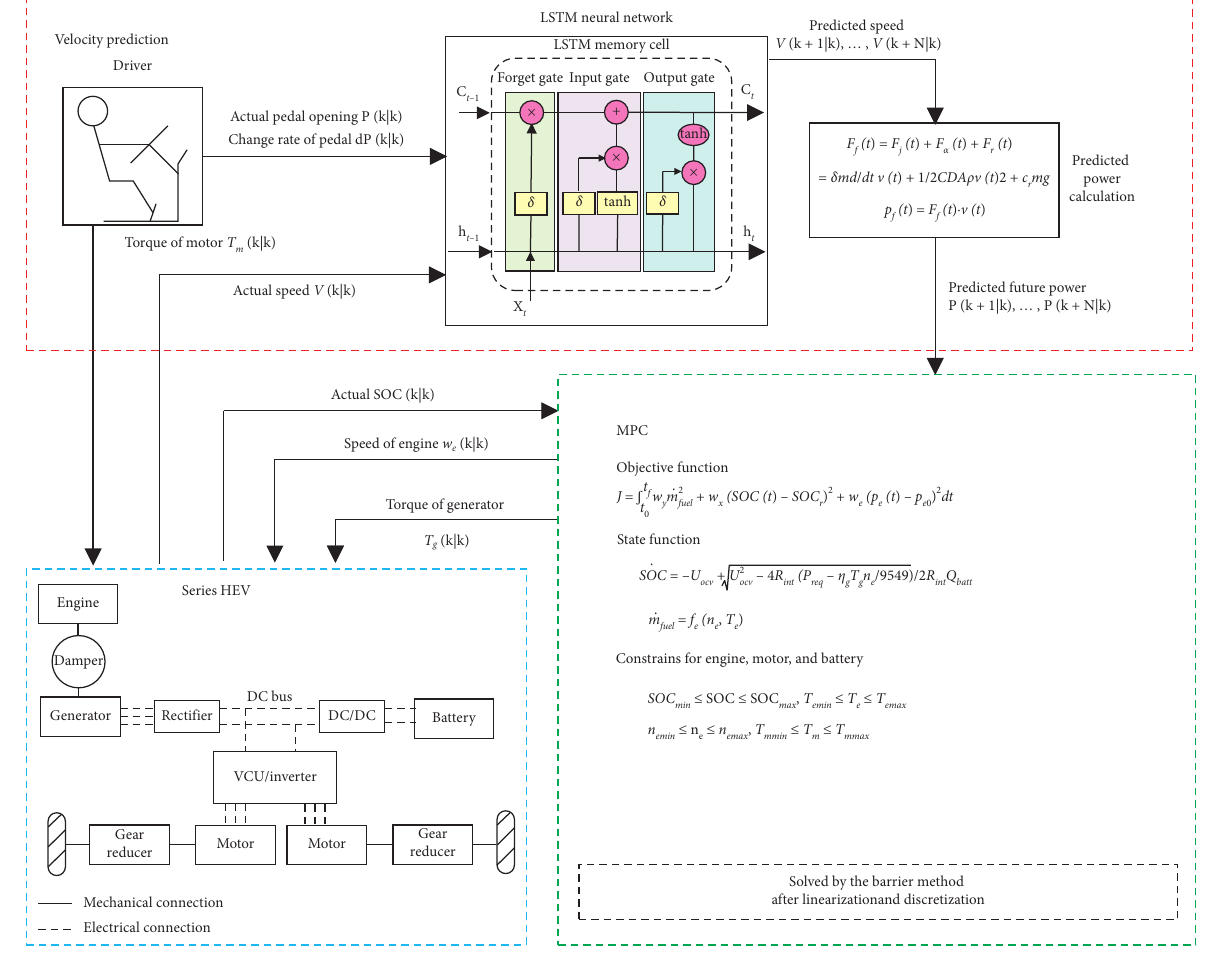
Figure 11: The framework of the real-time EMS based on driver-action-impact